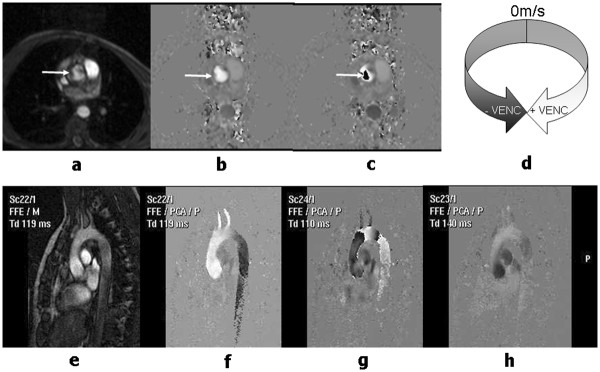
This figure illustrates some of the common pitfalls encountered with velocity-encoded MR imaging. Images (a) and (b) show a transaxial magnitude image and velocity map with ‘through-plane’ velocity encoding demonstrating forward flow in the ascending aorta (arrows). In (b), the maximum velocity is within the VENC chosen for the velocity-encoded acquisition, so that the phase shifts for all the pixels within the ascending aorta are less than 180° and are shown as high pixel intensities. In image (c), the VENC is set too low and the pixels at the centre of the ascending aorta (arrow) appear as negative velocities. This artefact, known as ‘velocity aliasing’ arises because phase shifts greater than 180° are interpreted as negative phase shifts and are mapped on to the lower pixel intensity scale (d). Images (e) and (f) show a magnitude image and velocity map acquired in an oblique sagittal plane to demonstrate flow in the aortic arch. The velocity encoding direction is chosen as ‘in-plane’ to demonstrate velocity components in the head-feet direction. In (f), the maximum velocity in both the ascending and descending aorta is lower than the VENC so that no aliasing is visible. For image (g) the VENC has been set too low resulting in velocity aliasing. For image (h) the velocity encoding direction has been incorrectly chosen to encode velocity components through the image plane, so that only relatively low transverse components of blood flow velocity are visible in the aorta.